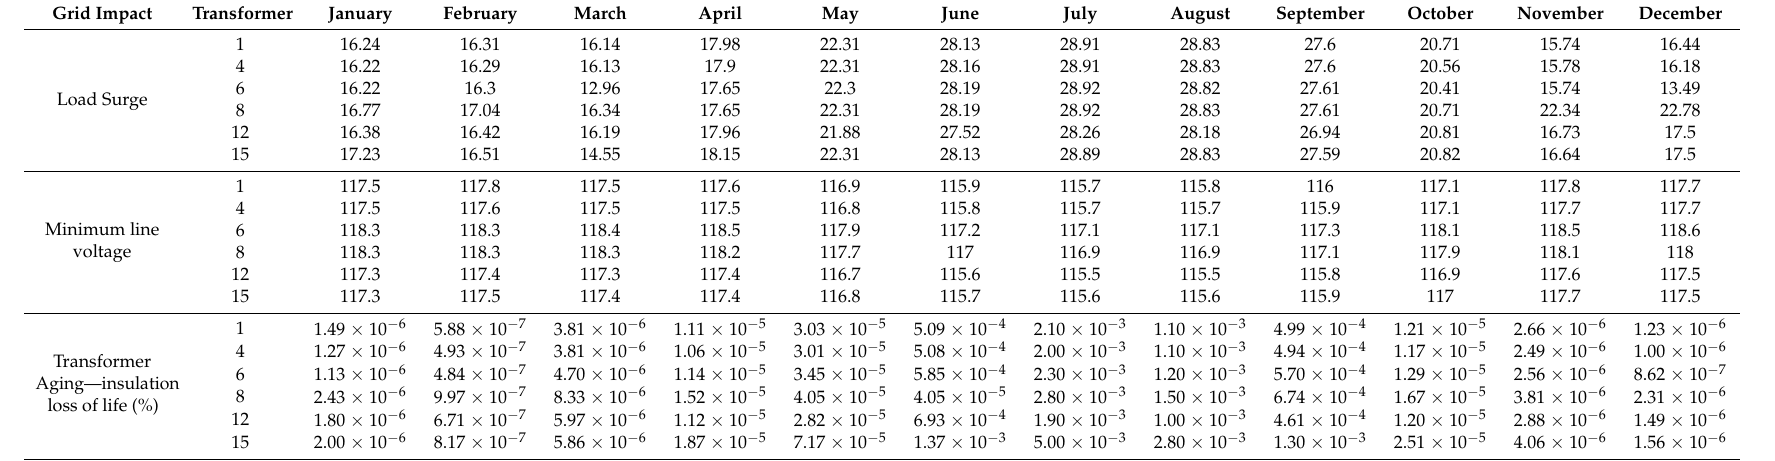
Table A5. Summary of the impact of 80% participation rate of optimal PEV charging in 12